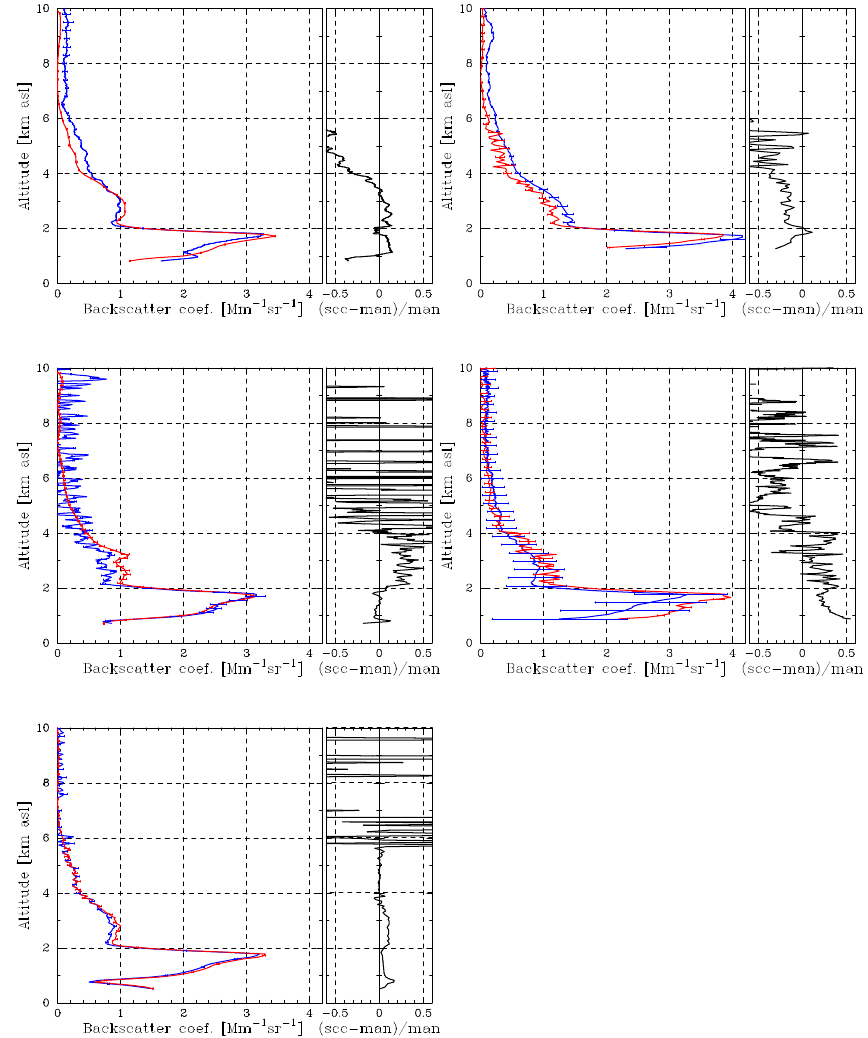
Figure 5. Comparison of backscatter coefficient profiles at 355nm derived with the Raman method for five lidar systems participating in the EARLI09 inter-comparison campaign. All profiles refer to the measurement session taken from 21:00 to 23:00UT on 25 May 2009, and they have been retrieved combining elastic-backscatter signals at 355nm and the corresponding N 2 Raman backscatter signals at 387nm. The profiles in blue are the analyses provided by the originator of the data using his/her own analysis software. The profiles in red are the ones retrieved by the SCC. From left to right, upper panel: RALI, MARTHA; middle panel: Polly XT , MSTL-2; bottom panel: